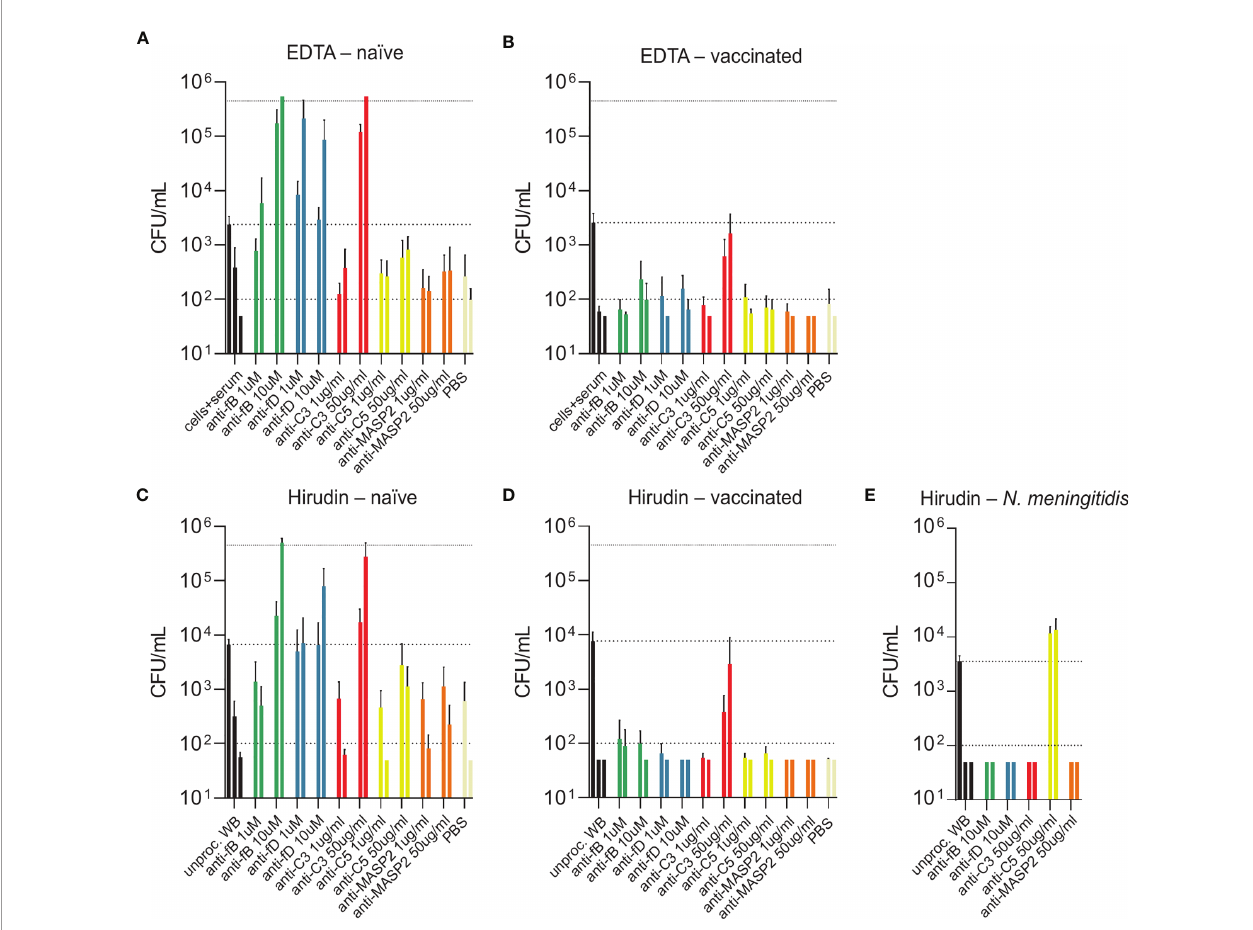
FIGURE 5 | Bacterial opsonophagocytosis in the presence of complement inhibitors. Effects of different complement inhibitors on pneumococcal killing were assessed in parallel with either DPBS-washed cells from EDTA-anticoagulated blood reconstituted with active serum (A, B) or with hirudin-anticoagulated whole blood (C, D) . Cumulated results for three individuals per group are shown. Meningococcal killing in the presence of complement inhibitors in hirudin-anticoagulated whole blood of a MenACWY-vaccinated volunteer (E) served as a control. Bars indicate bacterial CFU/mL at 3 and 5 h after inoculation (respectively, left and right bar for each condition). In the control conditions (black), the inoculum titer is depicted as the fi rst bar and further indicated as dashed line. Other dashed lines demonstrate the lower detection limit and the upper limit for bacterial quanti fi cation. WB, whole